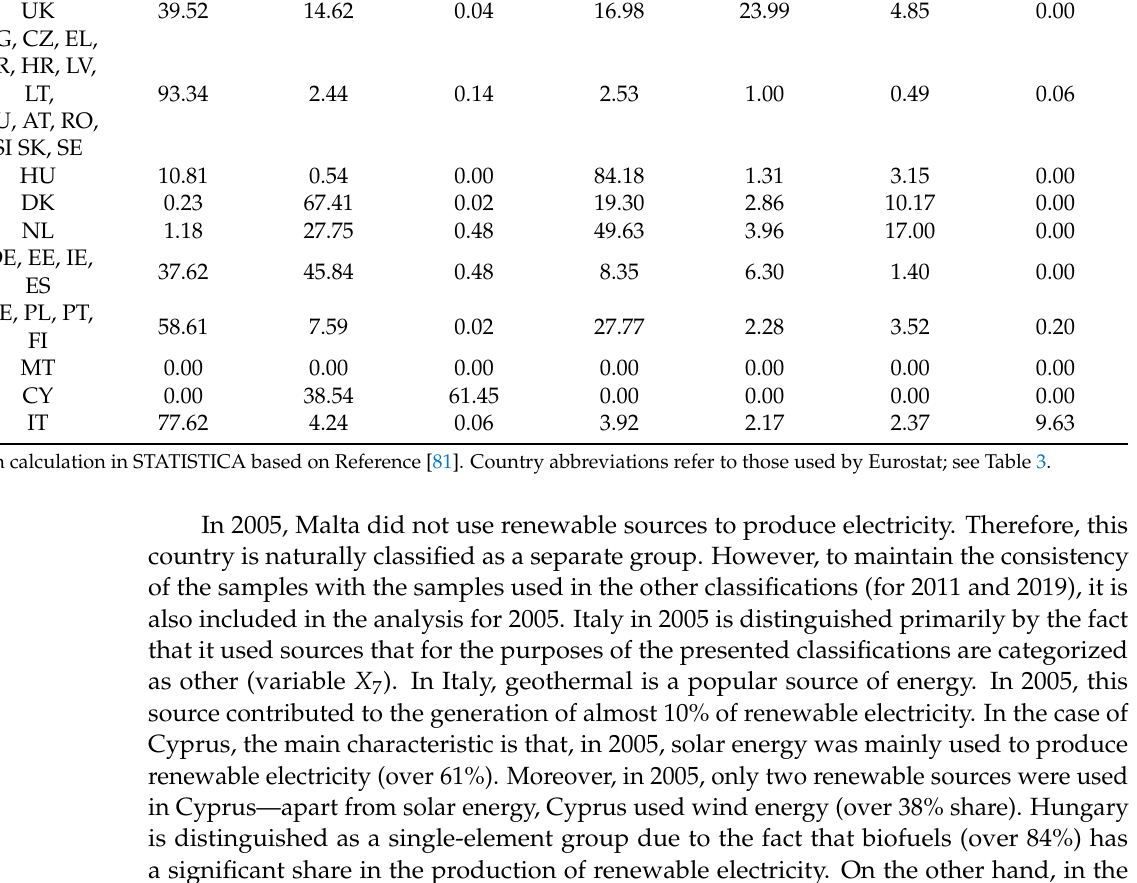
Source: Own calculations.